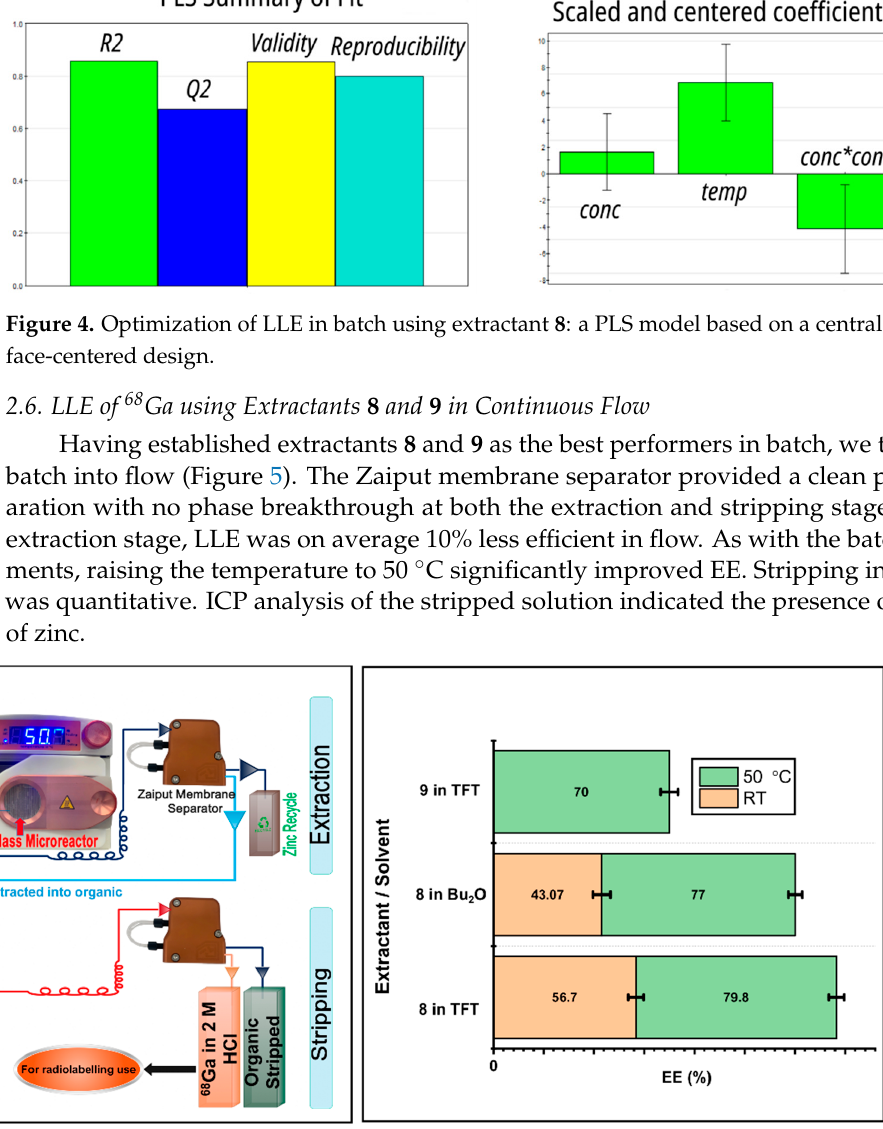
Figure 5. ( Left ) A schematic depicting two-stage liquid–liquid extraction in flow. ( Right ) 68 Ga EE (%) obtained from a 1 M Zn(NO 3 ) 2 solution in 0.01 M HNO 3 using extractants 8 and 9 in TFT and Bu 2 O at RT and 50 °C.